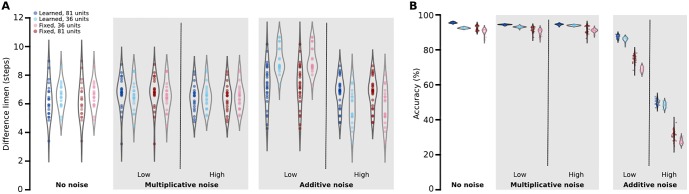
Model performance.Performance of 81- and 36-hidden unit models either trained on mixed stimuli or engineered with fixed Gaussian receptive fields on the (A) two-point discrimination and (B) alphabet classification tasks. (A) Data points show the difference limen, defined as the separation distance at which the model classifies 75% of 2000 test points correctly. (B) Data points show the overall classification accuracy of 7800 tested Roman letters. Grey violin plots show the frequency distribution of difference limens and accuracy across model iterations. Performance is reported at varying levels of multiplicative or additive noise (see Methods). Groups may have different numbers of data points as some networks failed to converge and were not considered for testing.